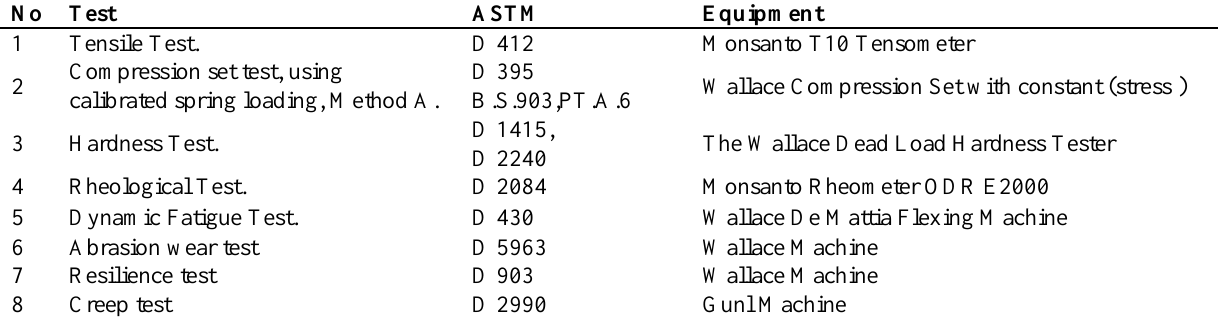
Equipments and Standard Test